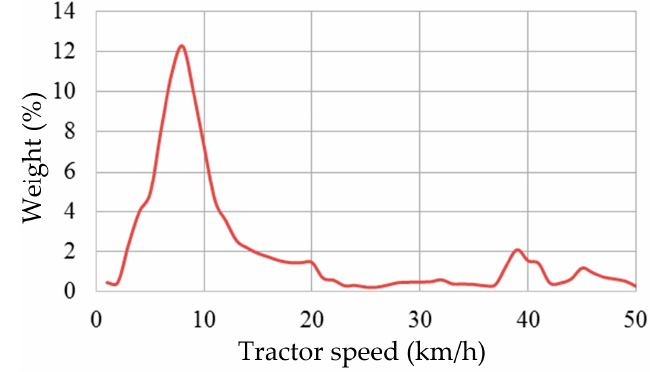
Figure 4. Calculation weight based on speed usage frequency.